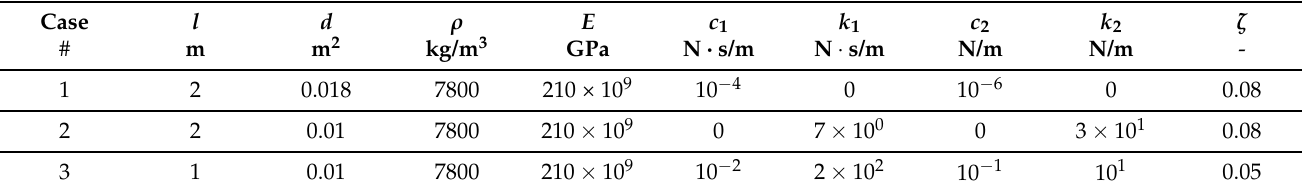
1 ,. . ., G k 1 are the 1 , . . . , G k 1 are the − − − −